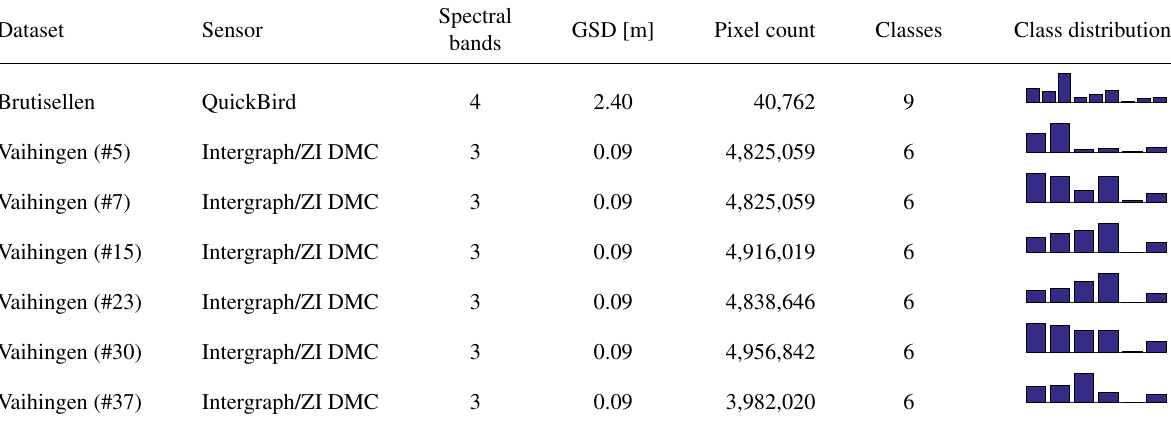
Table 4. Overview of the different datasets. All datasets are aerial images of urban areas. Pixel counts are without background. Classes in Brutisellen: residential, commercial, vegetation, soil, bare soil, roads, pools, parkings, vegetation2. Classes in Vaihingen: